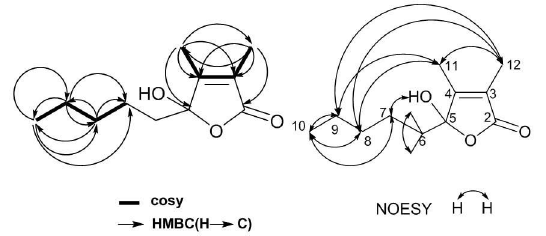
FIGURE 2 - 1 H- 1 H COSY, key HMBC and NOESY correlations of hydroxydihydrobovolide.